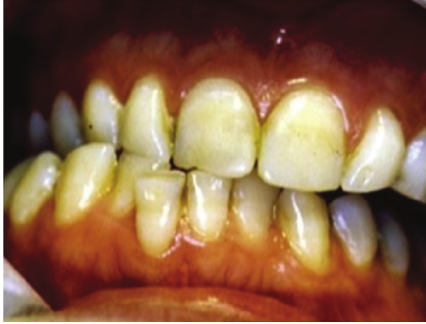
Figure 7: An extreme lateral mandibular movement past the canine edge-to-edge has resulted in the notch on the upper right central incisor.